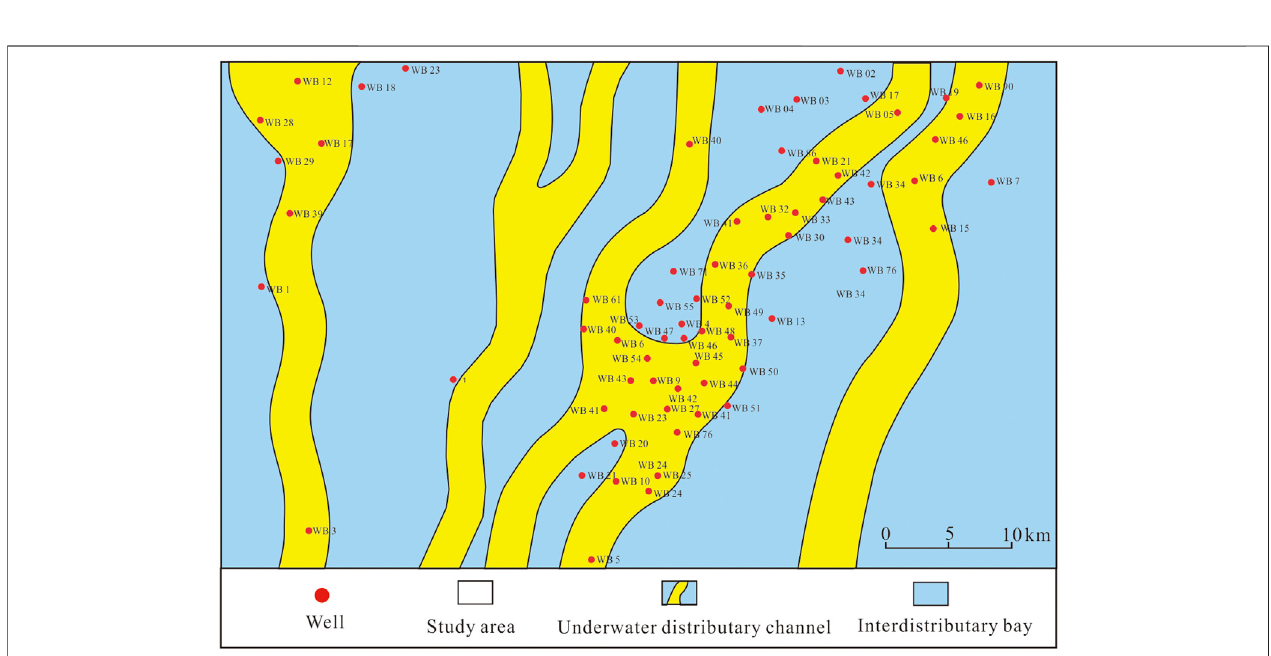
FIGURE 2 | Planar distribution of sedimentary facies in the Chang 3 Member of Weibei Oil fi eld.